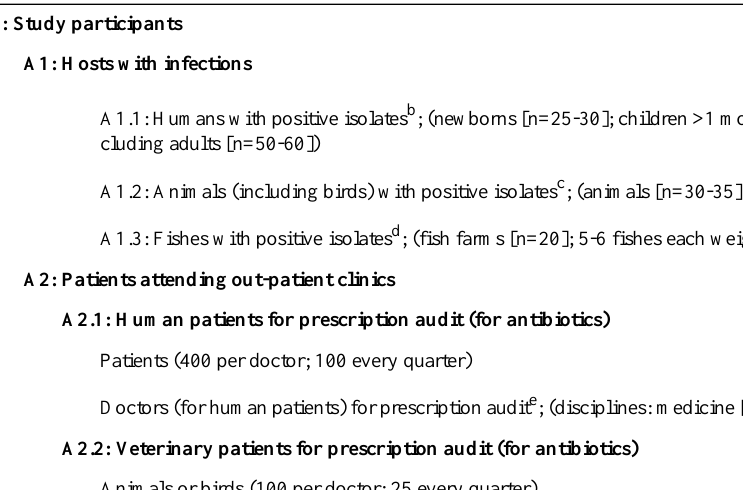
Table 1. The facilities and study participants for data collection under each category. NumberSerial no. and participant and facility